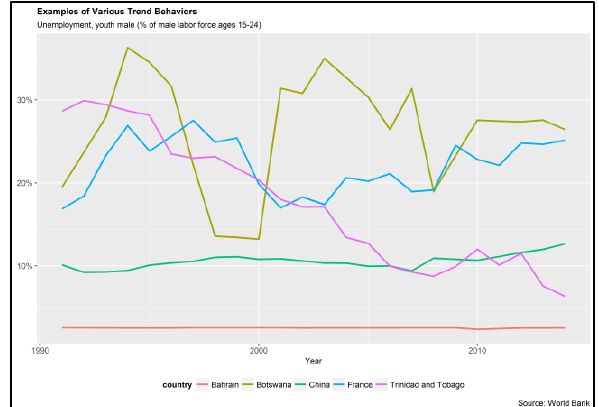
Figure 3. Examples of Various Trend Behaviors